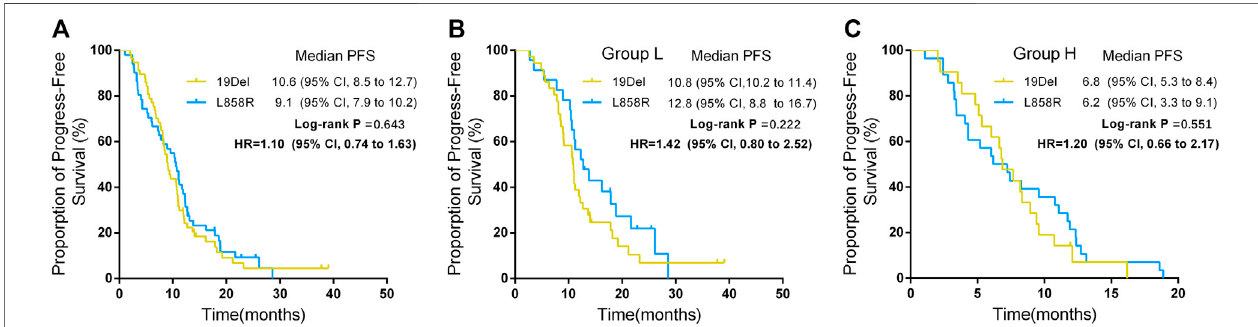
FIGURE 3 | Progression free survival (PFS) between different mutation sites and groups. (A) PFS between different mutation sites. (B) PFS between different mutation sites in group L. (C) PFS between different mutation sites in group H.